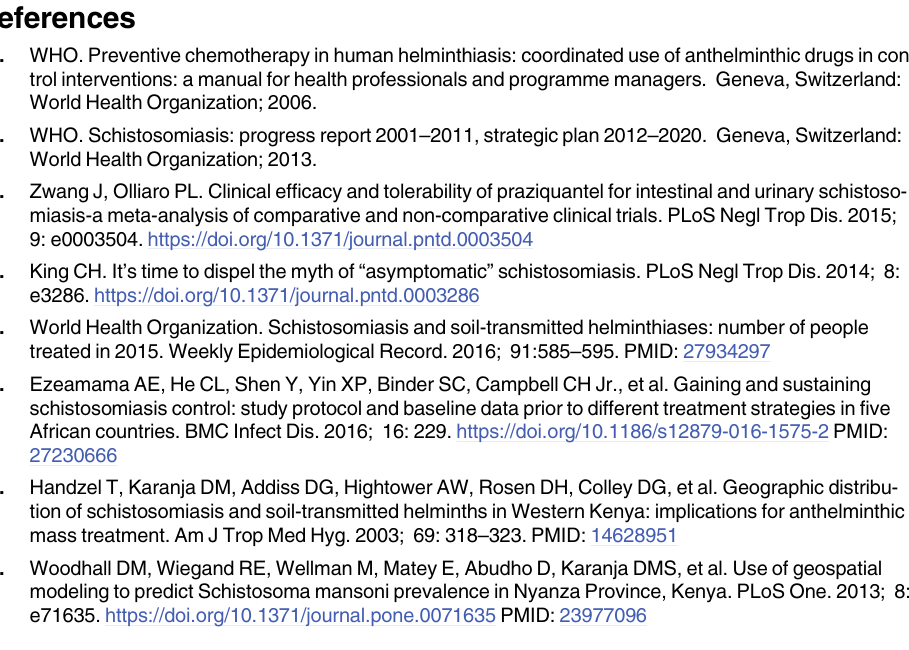
S3 Table. CONSORT 2010 checklist of information to include when reporting a cluster randomized